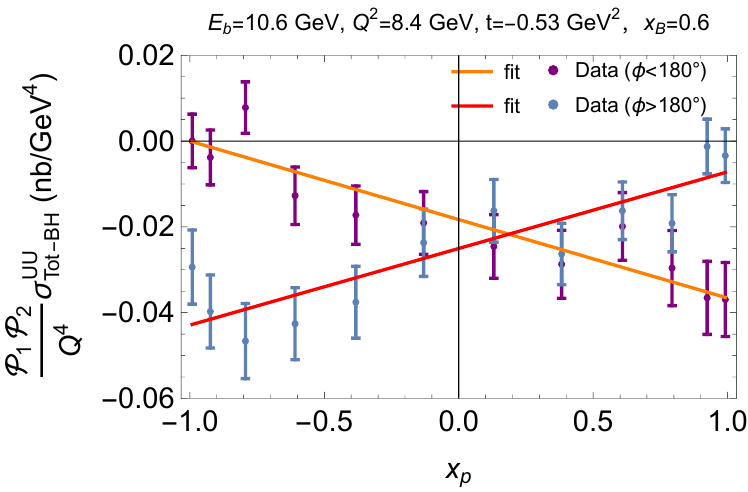
Figure 4. The results of fitting eqs. (4.4), (4.5) to the first bin of data for kinematical setting 603 from [38].